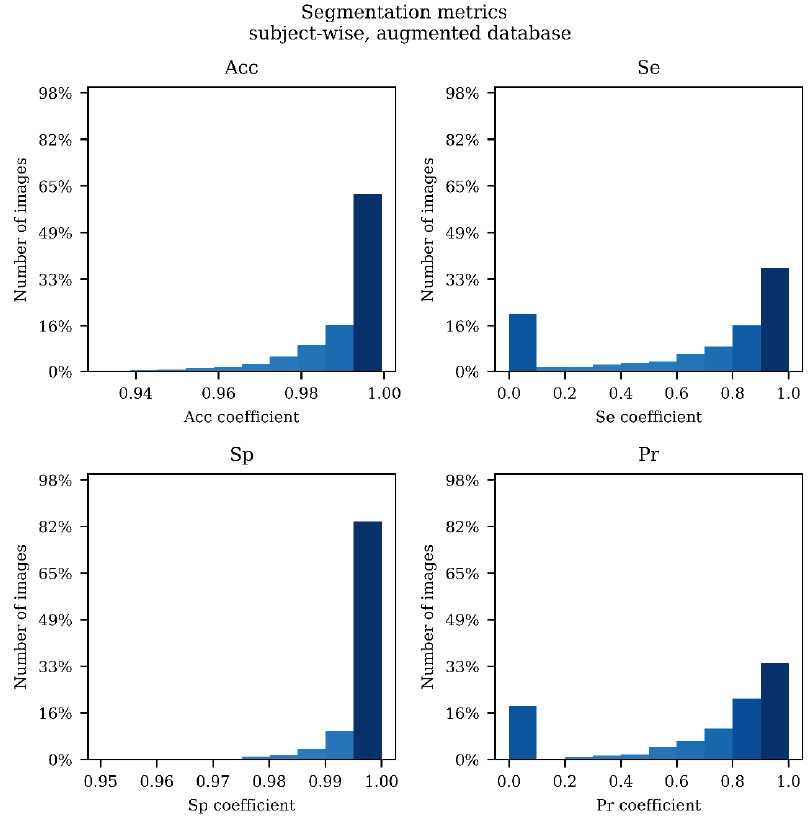
Figure A8. Histograms of metrics for segmentation results on a test set for a network trained on the augmented database with 5 -fold subject-wise cross-validation. Acc — accuracy; Se — sensitivity; Sp — specificity; Pr — precision.